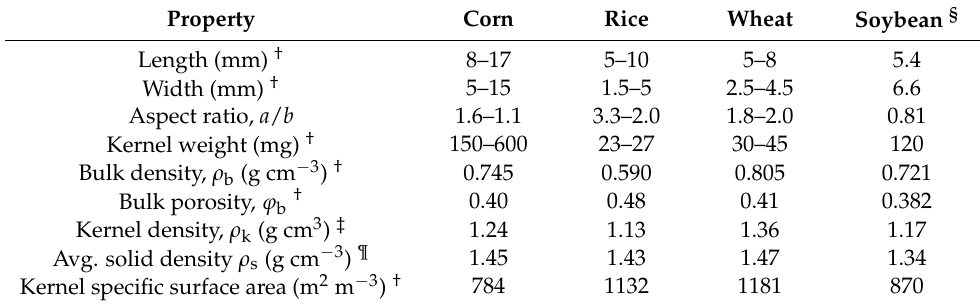
Table 4. Physical properties of corn, rice and wheat at 12–16% moisture content (wb).